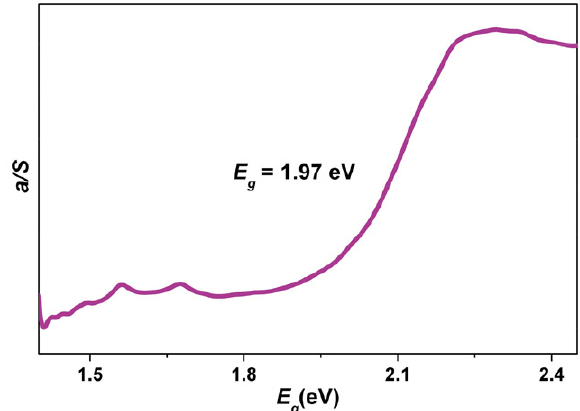
Figure 5. A solid-state diffuse reflectance spectrum for compound 1